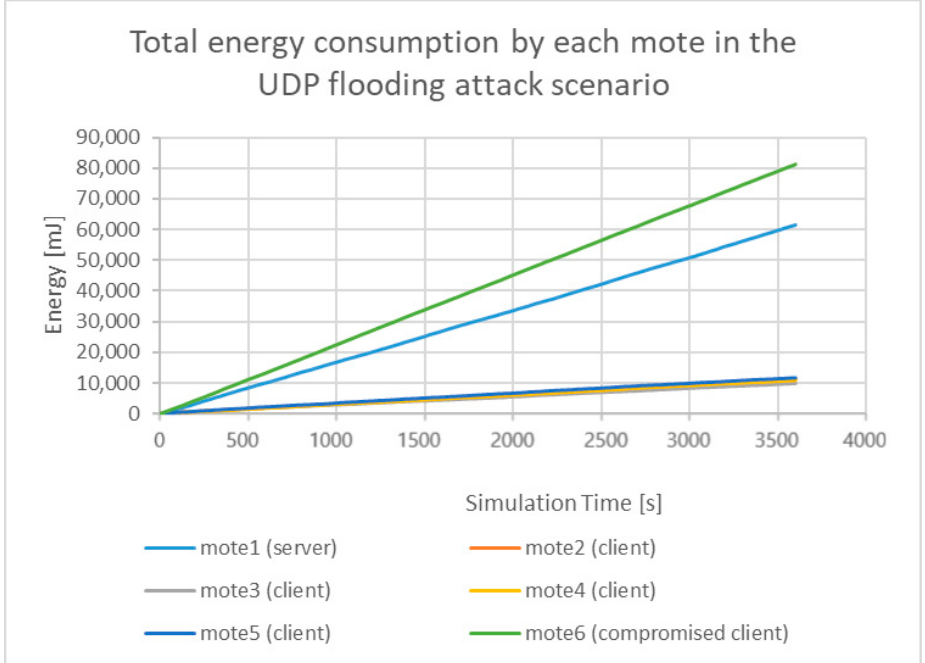
Figure 38. Total energy consumption by each mote in the UDP flooding attack scenario. Table 3 was extracted from the benign network traffic dataset (i.e., benign “radi- olog.csv”) and shows, in the last column, the percentage of the RPL messages overhead per mote which is calculated as follows: the number of RPL messages per mote over the total number of exchanged messages within the network during the simulation time